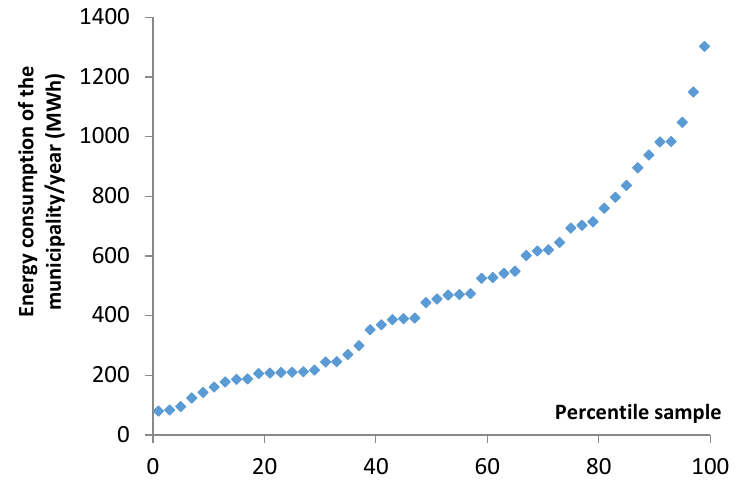
Figure 8. Normal probability test.